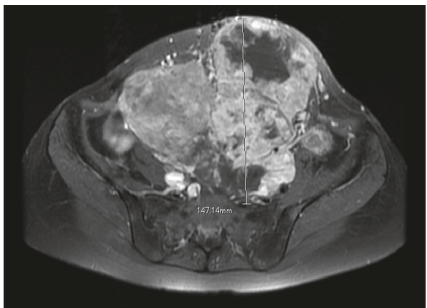
Figure 6: Magnetic resonance imaging findings (T1-weighted fat suppression gadolinium-enhanced image) after a drug holiday for six weeks. Tumor regrowth with increased enhancement was